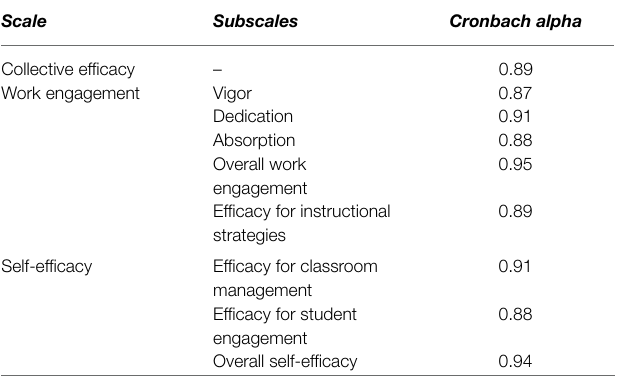
TABLE 4 | Results of Cronbach alpha indexes.